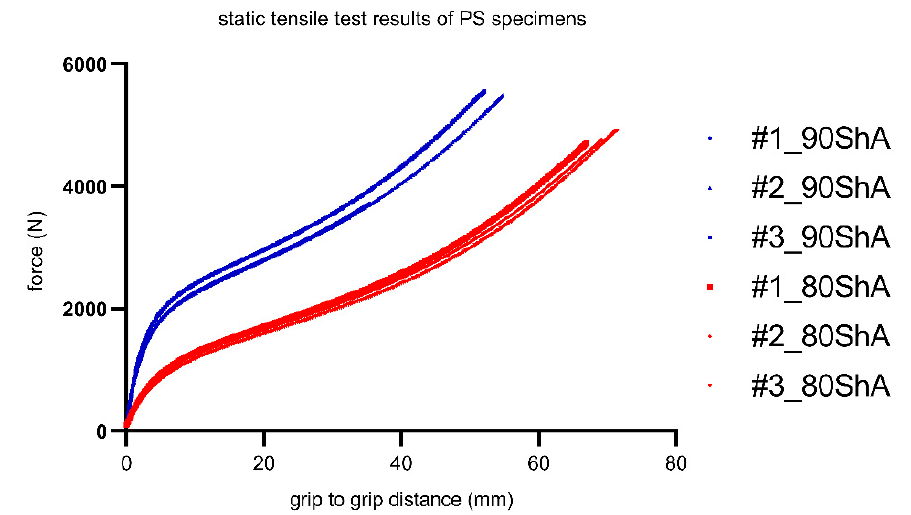
Figure 6. Static load–displacement curves for PS (pure shear) specimens.